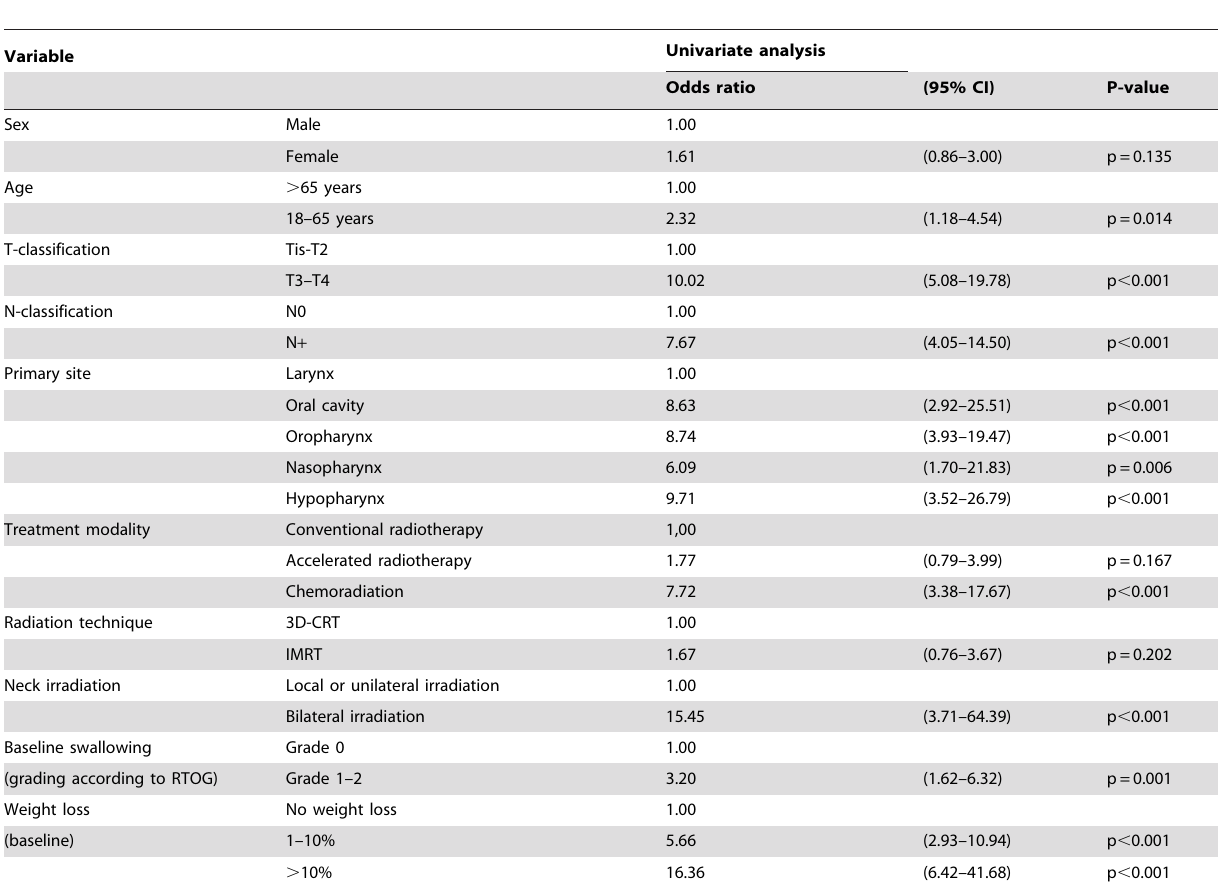
Table 2. Results of the univariate logistic regression analysis with tube feeding dependence at 6 months (TUBE M6 ) as primary endpoint in patients included in the training